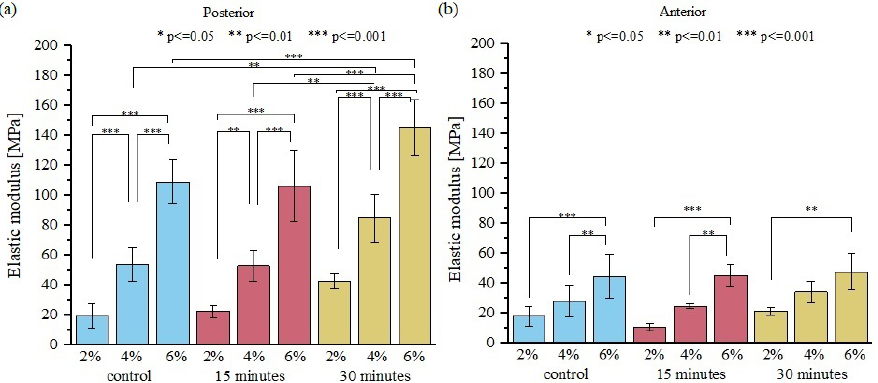
Figure 3. A comparison of elastic modulus obtained for ( a ) posterior side and ( b ) anterior side of the tendon for three different strain range/strain values for control samples and for samples dried for different times; n = 10.